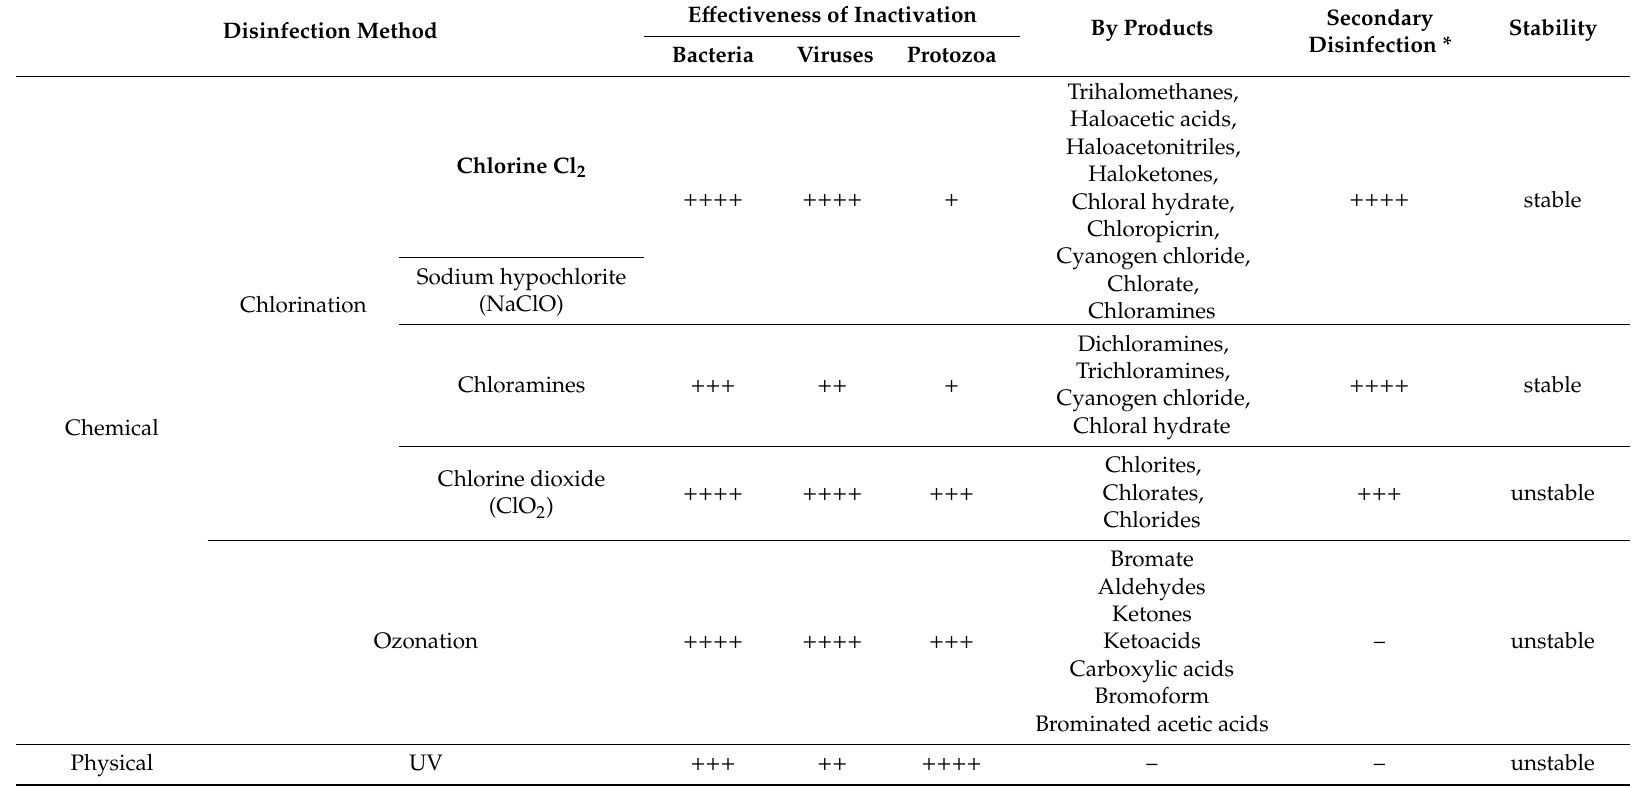
Table 10. General e ff ectiveness of commonly used disinfection processes